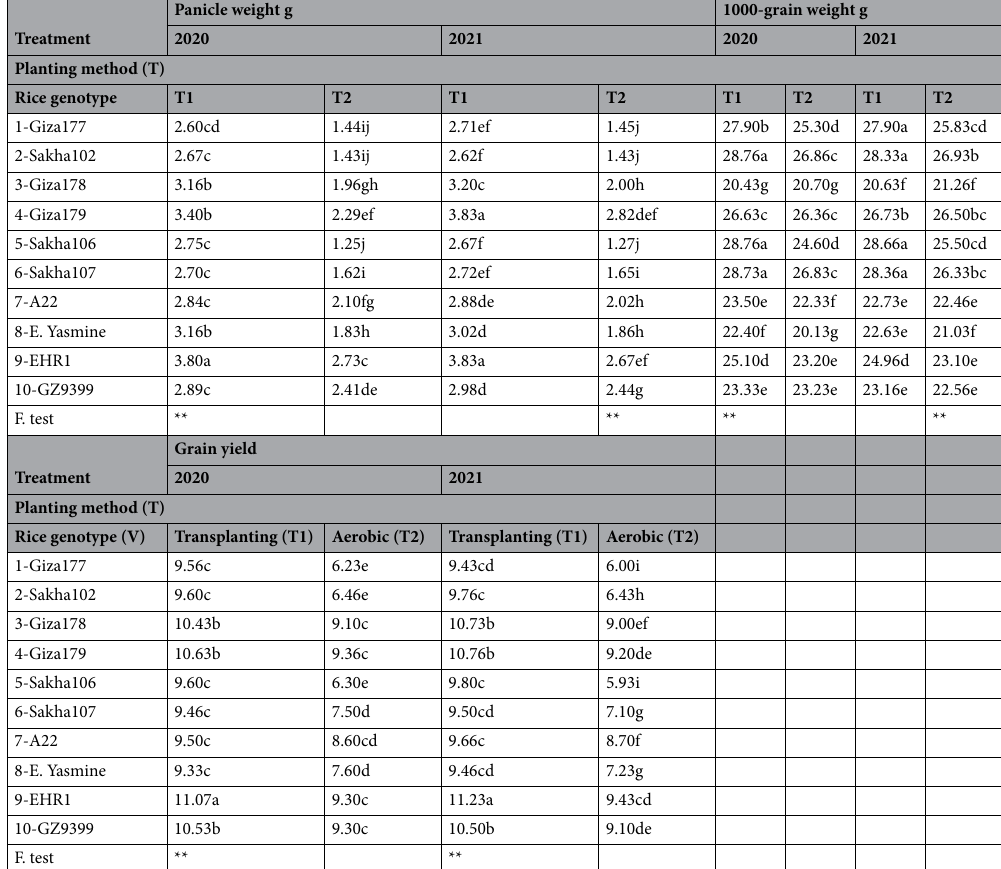
Table 16. Panicle traits and grain yield affected by the interaction between the study factors. T1 = Transplanting, T2 = Aerobic, **Significant at 0.01 level. Means followed by a common letter at the same column are not significantly different according to Duncan ’ s multiple range at 0.05